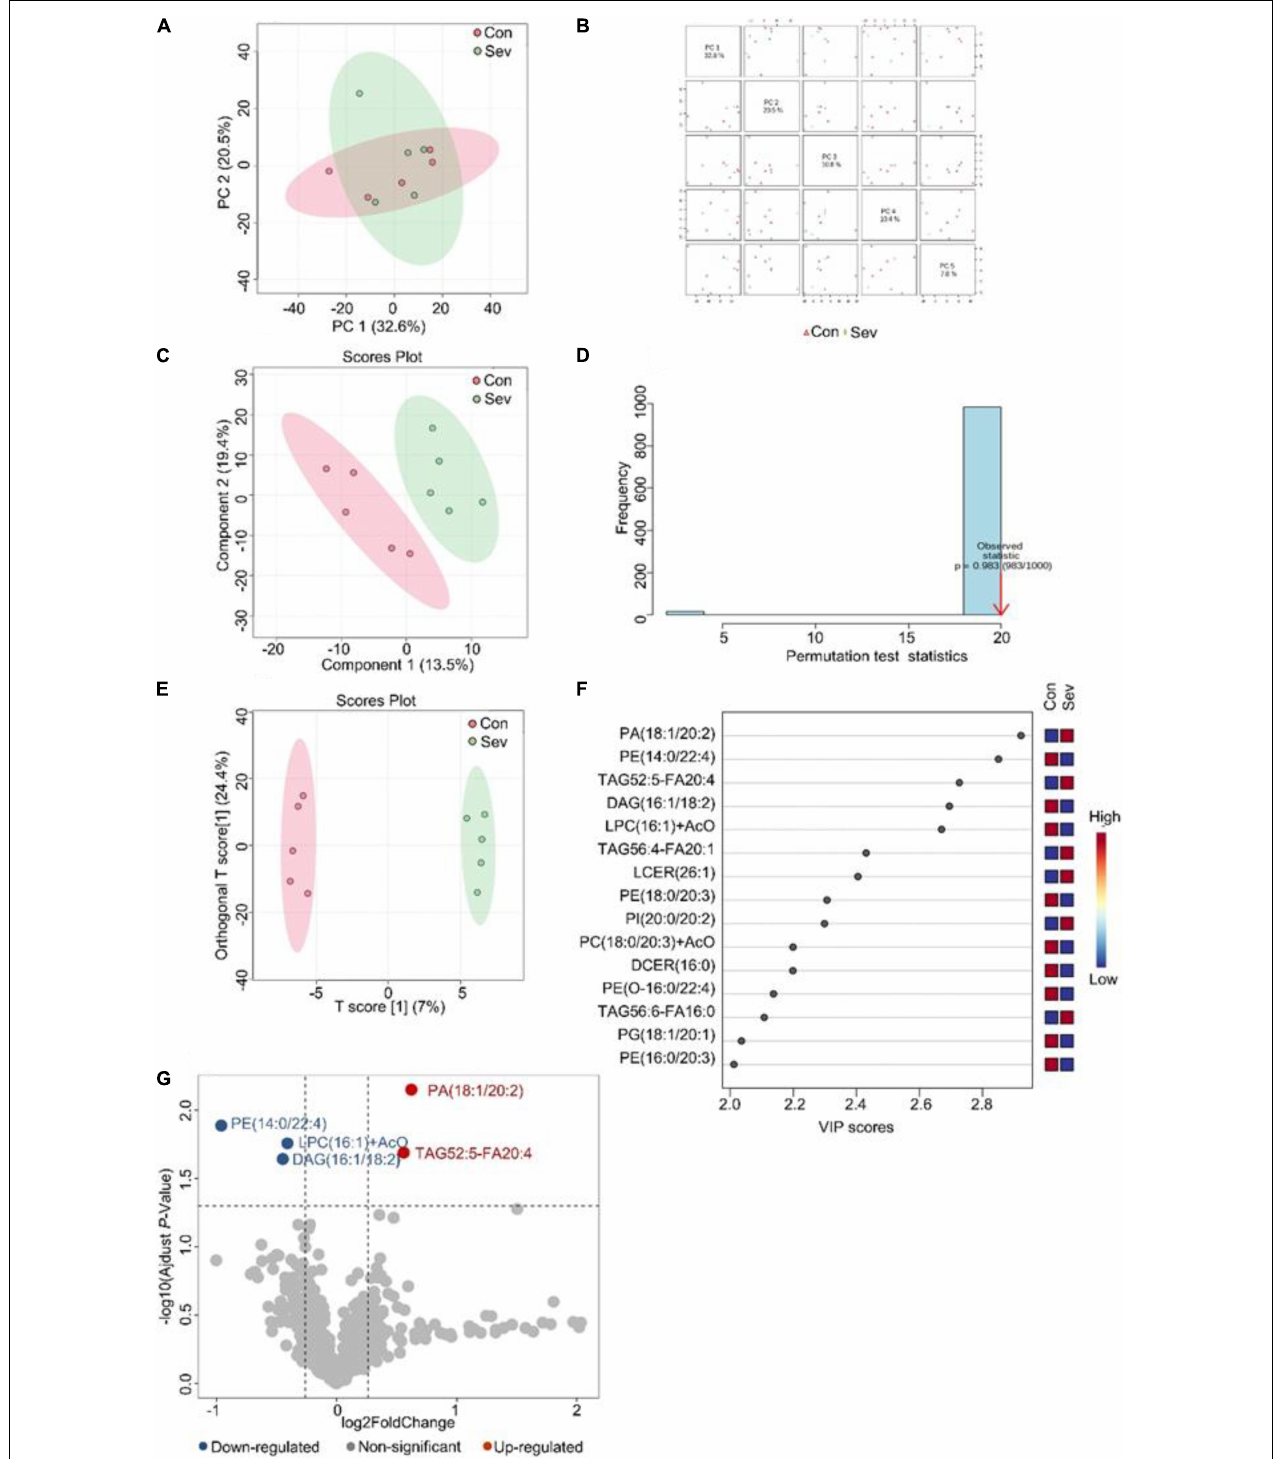
FIGURE 2 | Analysis of lipidomics in the prefrontal cortex of aged mice. (A) Two-dimensional score diagram of PCA analysis of sevoflurane anesthesia group and control group in prefrontal cortex of aged mice. (B) Pairwise score chart of the top five principal components of PCA. (C) PLS-DA 2D score chart. (D) Permutation test results of PLS-DA Model 1000 times. (E) OPLS-DA 2D score chart. (F) The top 15 lipids ranked by VIP value of the OPLD-DA model. (G) In volcano analysis, red dots indicated the lipid components significantly increased in the sevoflurane group compared with the control group (fold-change > 1.2, P < 0.05); blue dots indicate significantly lower lipid components in the sevoflurane group (fold-change < 0.83, P < 0.05).